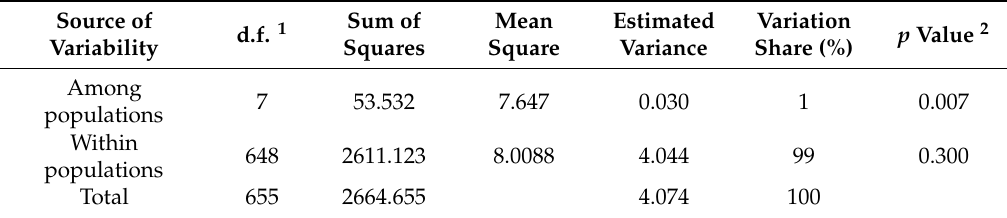
Table 7. Analysis of molecular variance (AMOVA) results for genetic variation between and among investigated